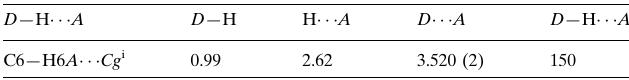
Hydrogen-bond geometry (A˚ , (cid:2) ). Cg is the centroid of the aromatic